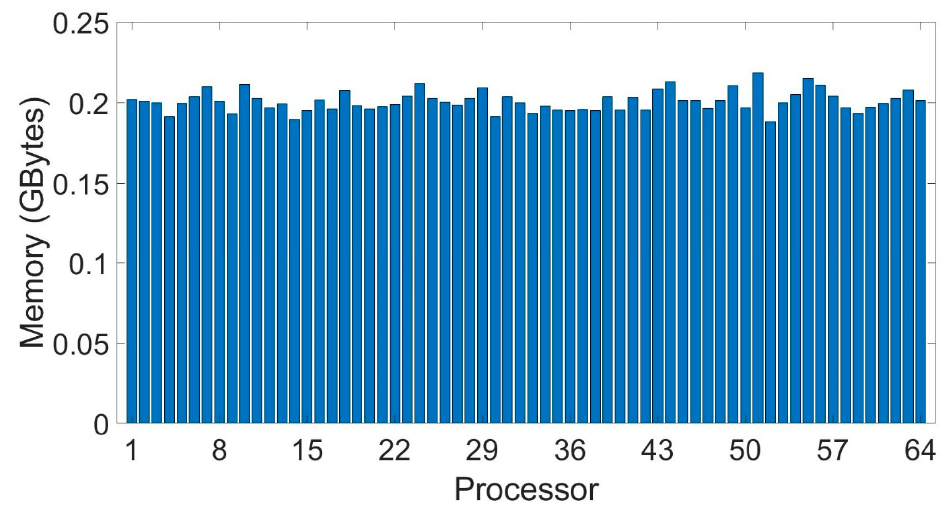
Figure 20. Testcase#2. The Memory/Computation load versus MPI processors used in computation.